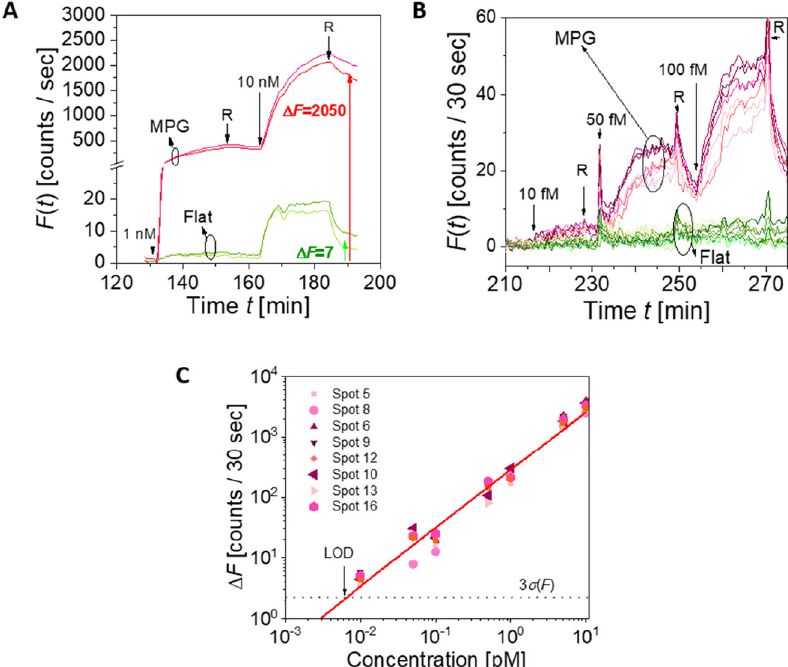
Figure 7: Biomolecular binding kinetics observed for a model IgG – anti-IgG on the MPG surface. The fluorescence reader was configured for detection of (A) high fluorescence intensities and (B) low fluorescence intensities for which the respective (C) calibration curve was established. The caption R states for the rinsing and red curves correspond to data measured on the MPG surface and green curves on the reference flat gold